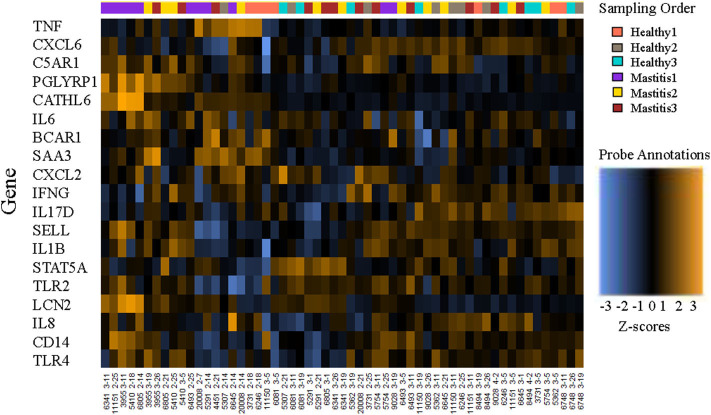
Heatmap of the normalized data, scaled to give all genes equal variance, generated via unsupervised clustering. Orange indicates high expression; blue indicates low expression. This plot is meant to provide a high-level exploratory view of the data.